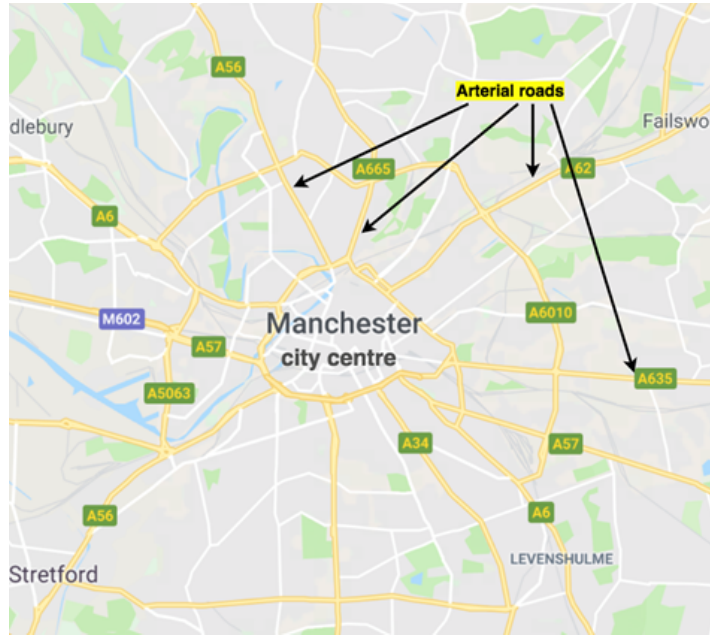
Figure 1. Manchester city arterial roads.